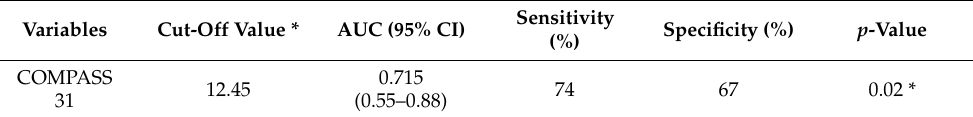
Table 5. Sensitivity, specificity, and area under the curve obtained using ROC analysis for the use of composite autonomic symptom scale 31 in predicting modified CASS-based cardiovascular autonomic